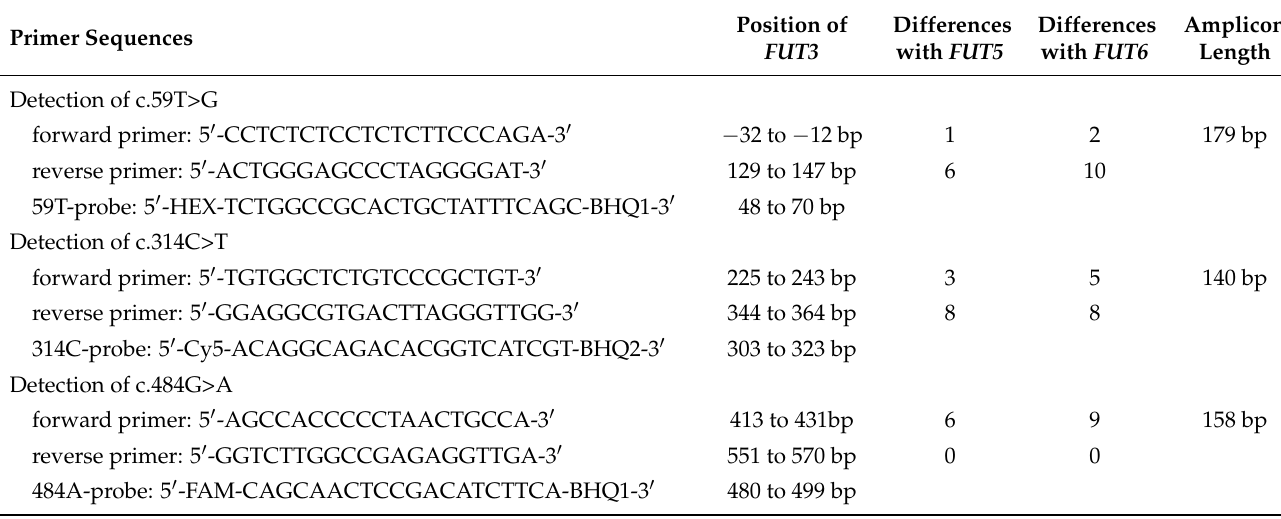
Table 1. Primers and probes for detection of SNPs in FUT3